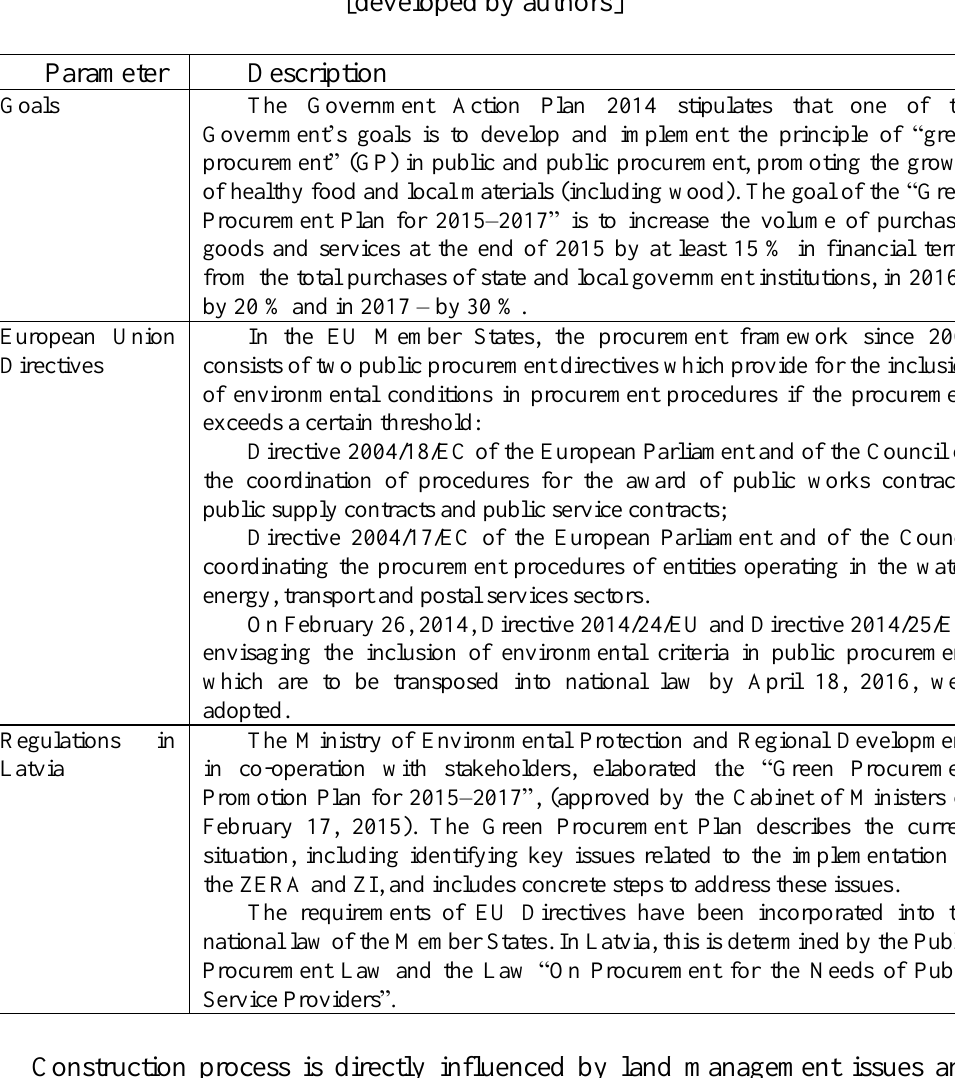
Table 3. Green public procurement aims, EU directives and regulations in Latvia (The Ministry of Environmental Protection and Regional Development,